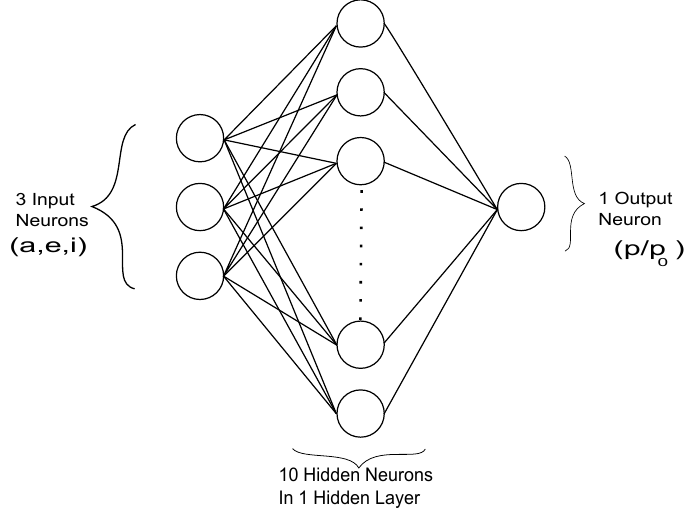
Figure 5. Schematic of the artificial neural network architecture used for the